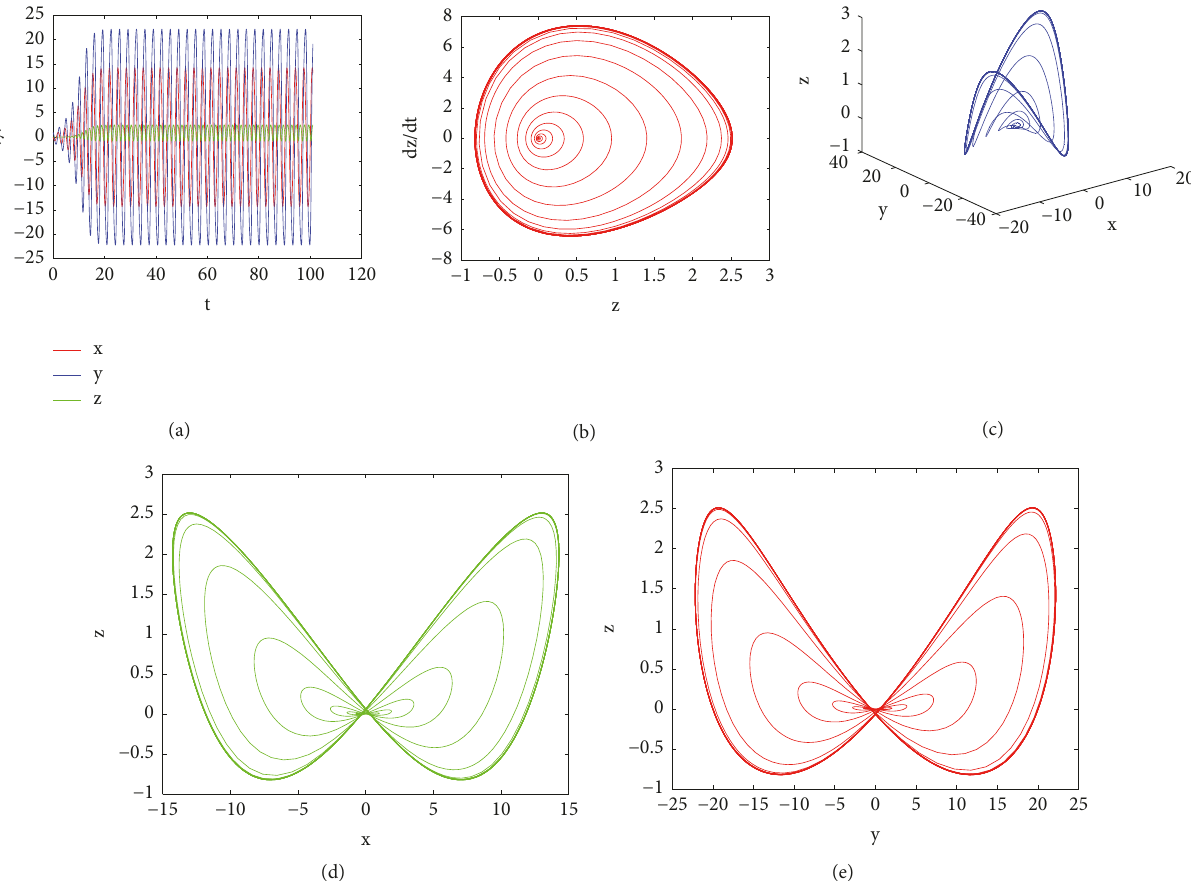
Figure 3: Lorenz system for Experiment 1 at 𝑐 = 100 : (a) time series plot; (b) phase diagram of 𝑧 ; (c) on the three-dimensional space; (d) projected on the (𝑥,𝑧) -plane; (e) projected on the (𝑦, 𝑧) -plane.